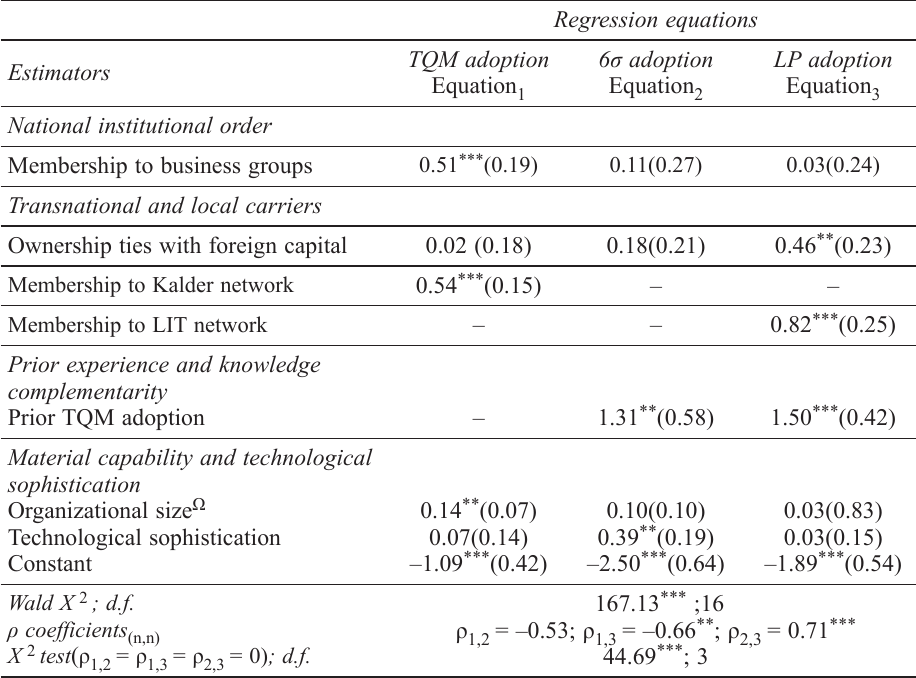
Table 2. Multivariate probit regression model estimates of TQM, 6σ and LP adoption